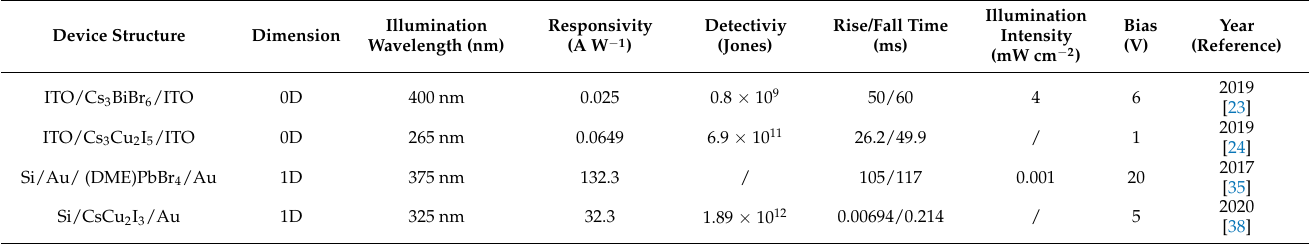
Table 2. Performances of low-dimensional perovskite photodetectors based on the above